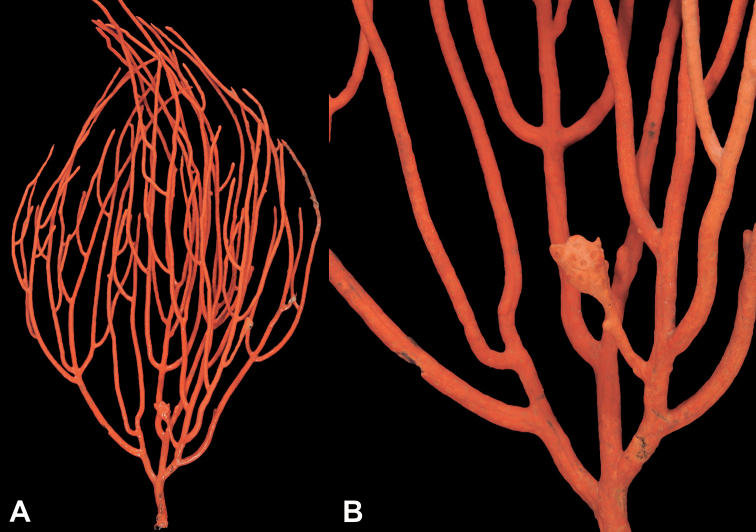
Leptogorgiachilensis, SBMNH 422953. A Colony measures 25 cm, maximum length, 13.5 cm, broadest width B Detail of branching pattern (branch diameter ≤ 2.0 mm), and gall formation created by species of barnacle, a common occurrence on this and other gorgonian species.